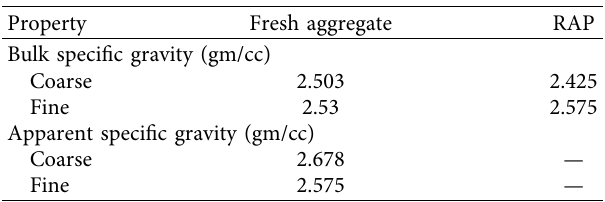
Figure 1: Research approach flow chart. Table 1: Aggregate properties.